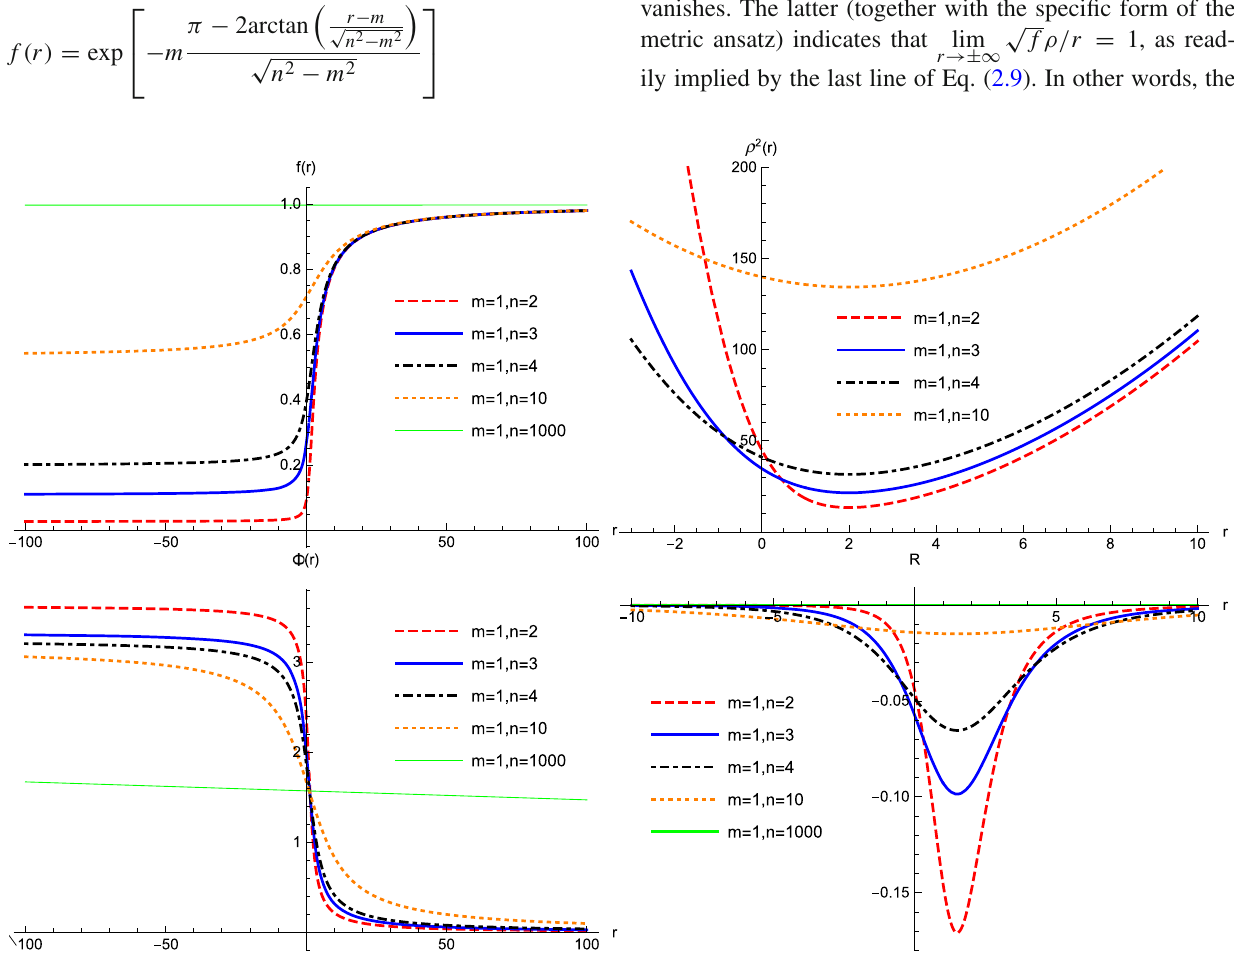
Fig. 1 The obtained Ellis drainhole solution as a function of the radial coordinate r for m = 1 and different values of n . The calculations are carried out for the metric functions f ( r ) and ρ 2 , the Ricci scalar R , and the scalar field